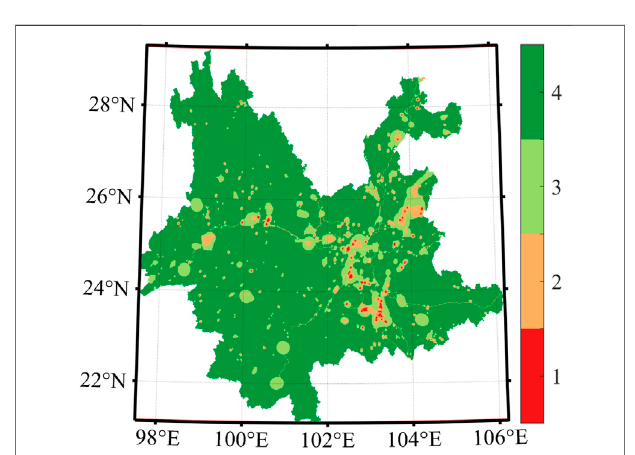
FIGURE 2 | Manually drawn map of the pollution distribution in Yunnan Province by the electric power department in 2018.